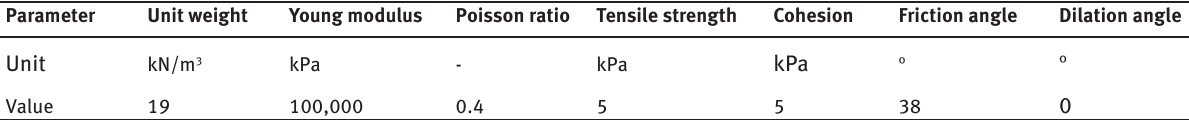
Table 1: Material parameters used for numerical simulation.